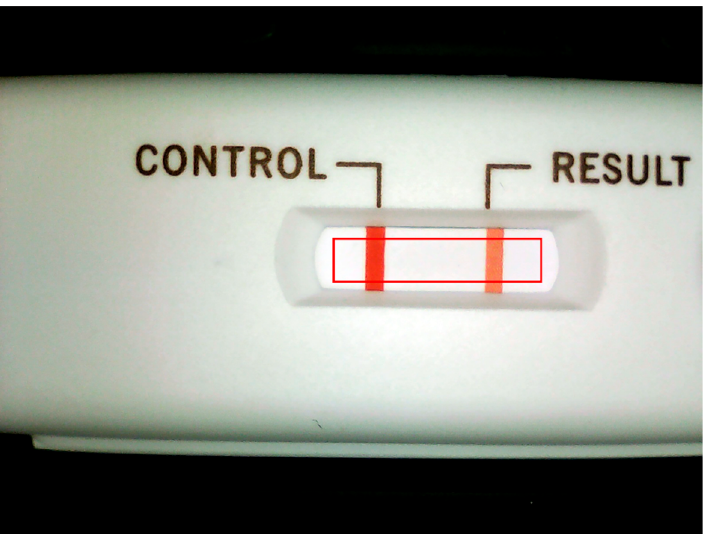
Figure 3. Captured image of the cassette with the region of interest (ROI) area marked with a red line.